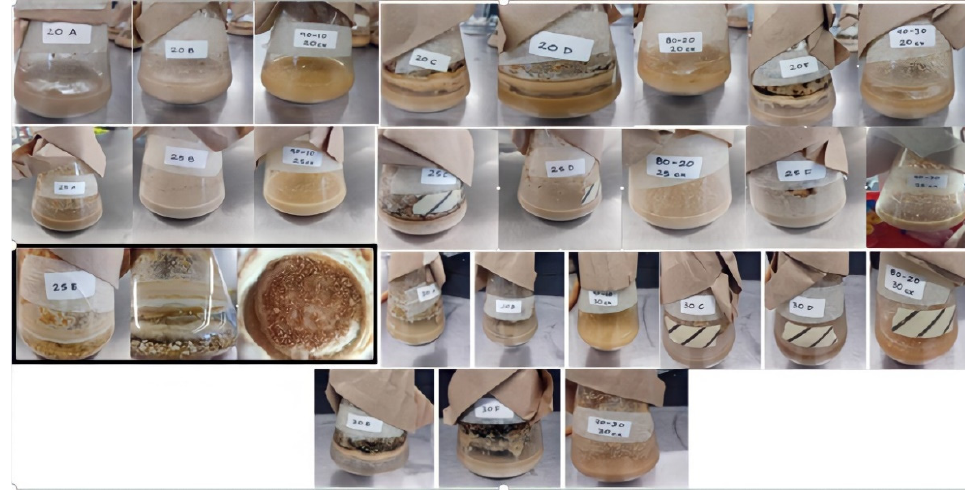
Figure 1. Qualitive analysis of the samples of blue corn ( Zea mays L.) flour with Colletotrichum gloe- osporioides . In the black box in the figure, it shows the jellification